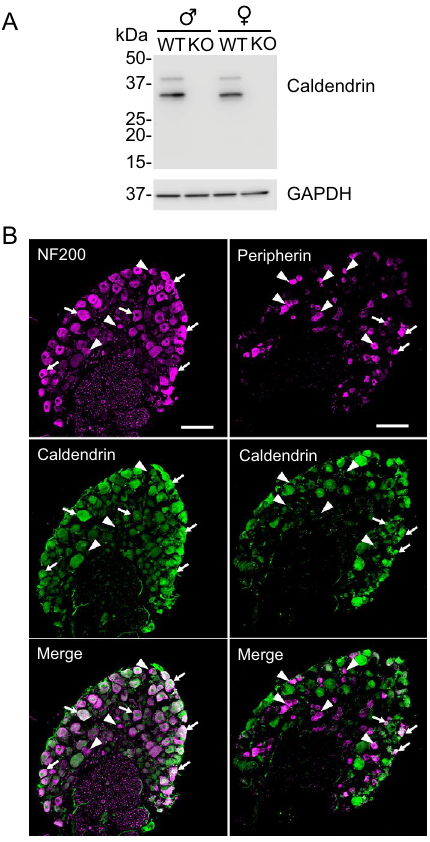
Figure 1. Caldendrin is expressed primarily in myelinated DRGNs. ( A ) Western blots of DRG lysates from WT and caldendrin KO mice probed with antibodies that recognize all CaBP1 variants (upper panel) or GAPDH to ensure equal loading of protein between lanes (lower panel). 36- and 33- kDa bands corresponding to caldendrin were detected in WT but not in caldendrin KO lysates whereas bands corresponding to CaBP1 variants were not observed. The gel images correspond to a single blot that was sequentially probed with anti- caldendrin and anti- GAPDH antibodies (Supp. Figure S1A). ( B ) Confocal micrographs of DRG cryosections from WT mouse double-labeled with antibodies against caldendrin and NF200 or peripherin. Arrows and arrowheads indicate cells in which caldendrin is or is not, respectively, co-localized with NF200 or peripherin. Results are representative of at least 3 independent experiments. Scale bar, 100